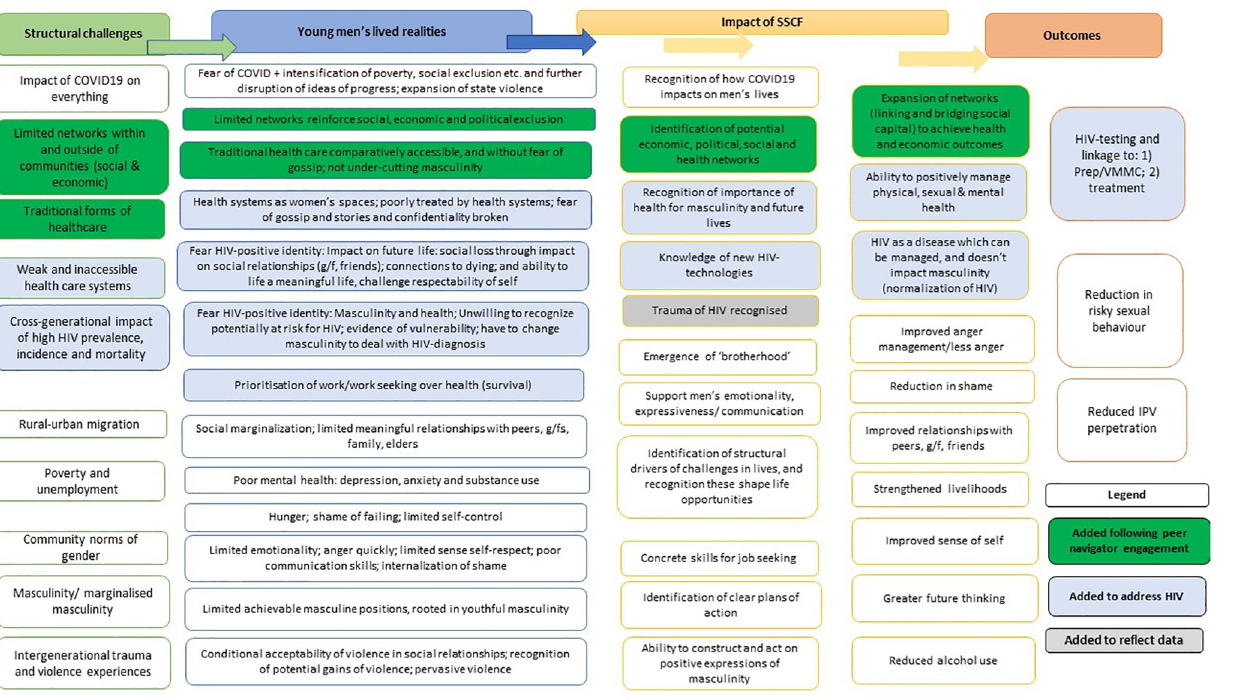
Fig 2. Theory of Change for Stepping Stones and Creating Futures including its changes over the project